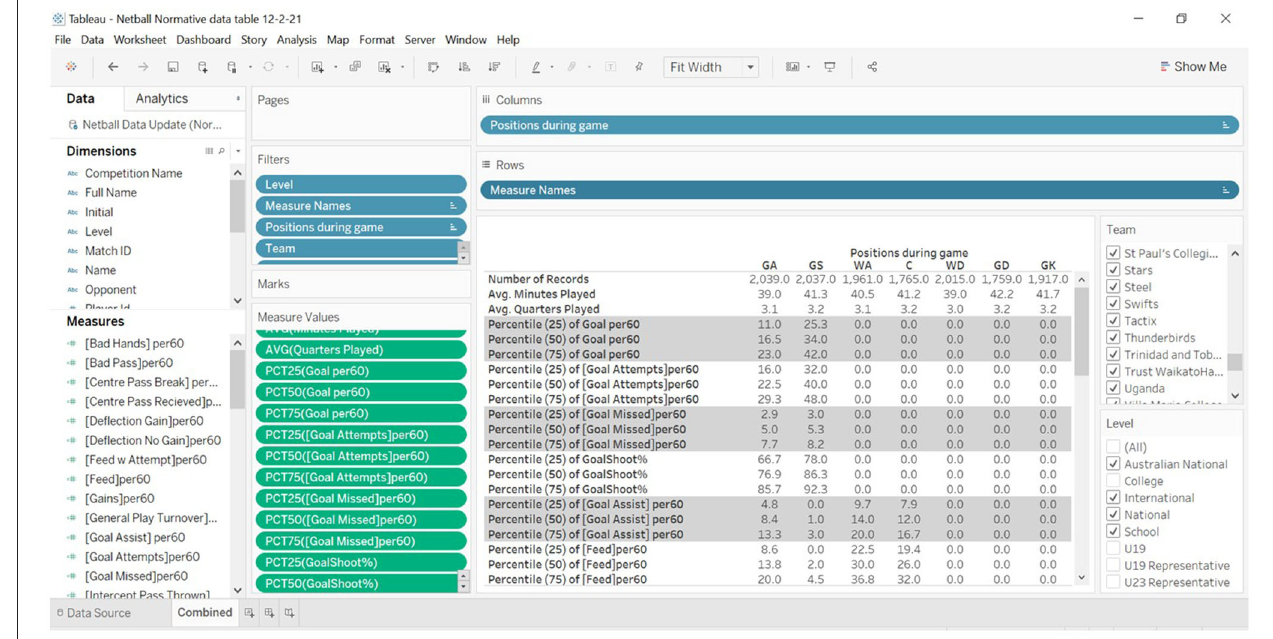
Frontiers in Sports and Active Living |